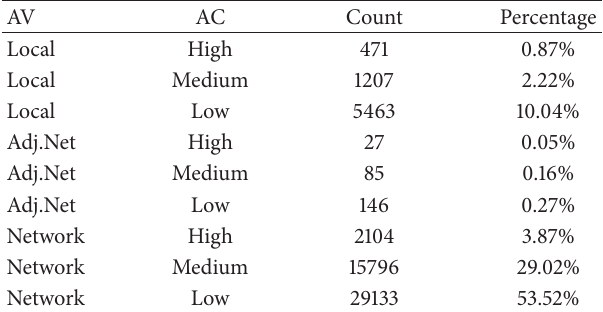
Table 2: Input data for Chi-square analysis.